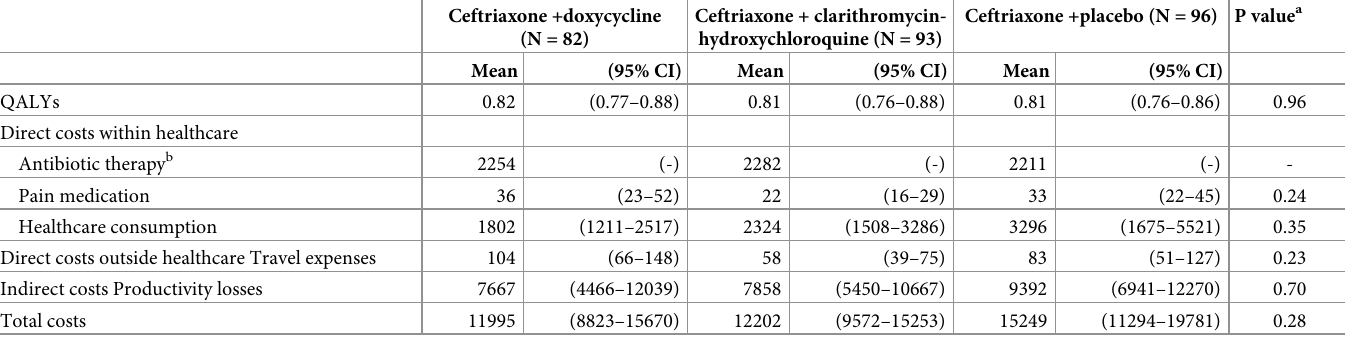
Table 2. Mean QALYs and costs (in euro’s) per patient over the 1-year follow-up